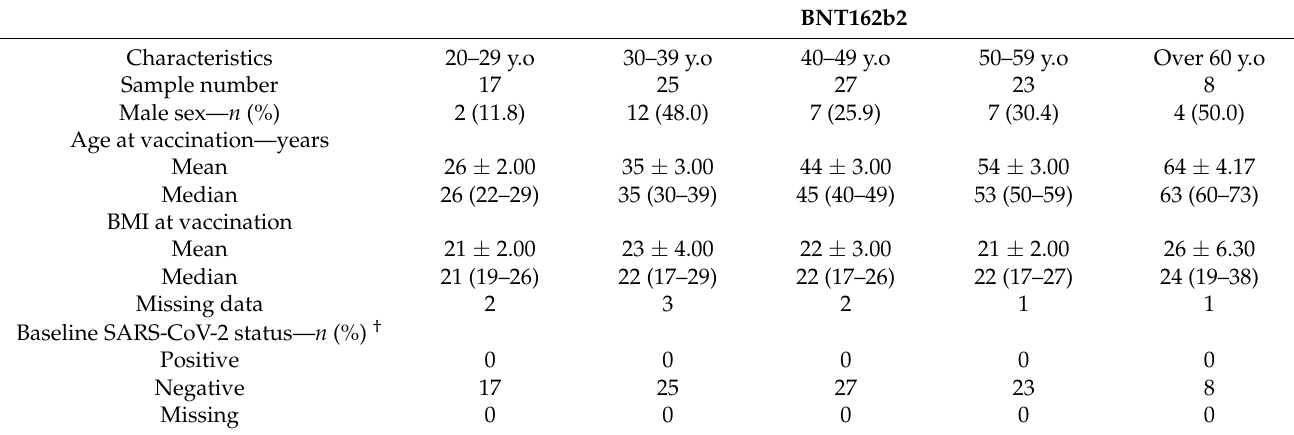
Table 1. Basic characteristics of study